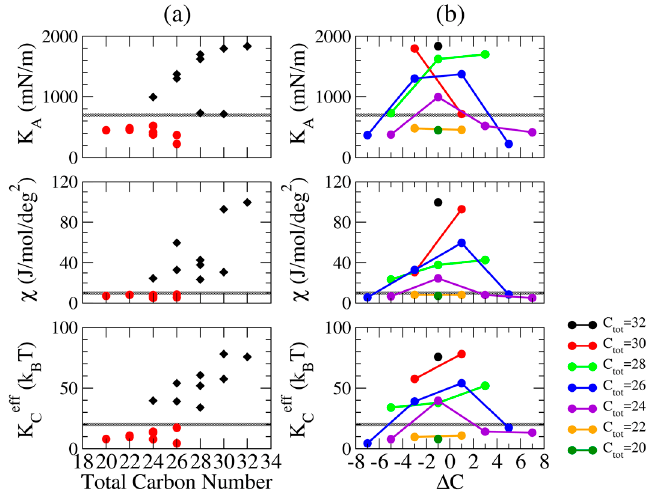
Figure 10. The area expansion modulus K A (top panel), the molecular tilt modulus χ (second panel) and the effective bending rigidity K ef f (bottom panel) for all the tested IPA systems with respect to ( a ) total number of carbon atoms where IPA bilayers in S and Ld phases at 298 K are colored in black diamonds and red dots, respectively, and ( b ) ∆ C in which each line represents systems with equal total alkyl carbon numbers. The gray line represents the threshold values of K A = 700 mN/m, χ = 10 J/mol/deg 2 , and (cid:1837) (cid:3004)(cid:3032)(cid:3033)(cid:3033) = 20 k B T to distinguish the Ld and S phases.